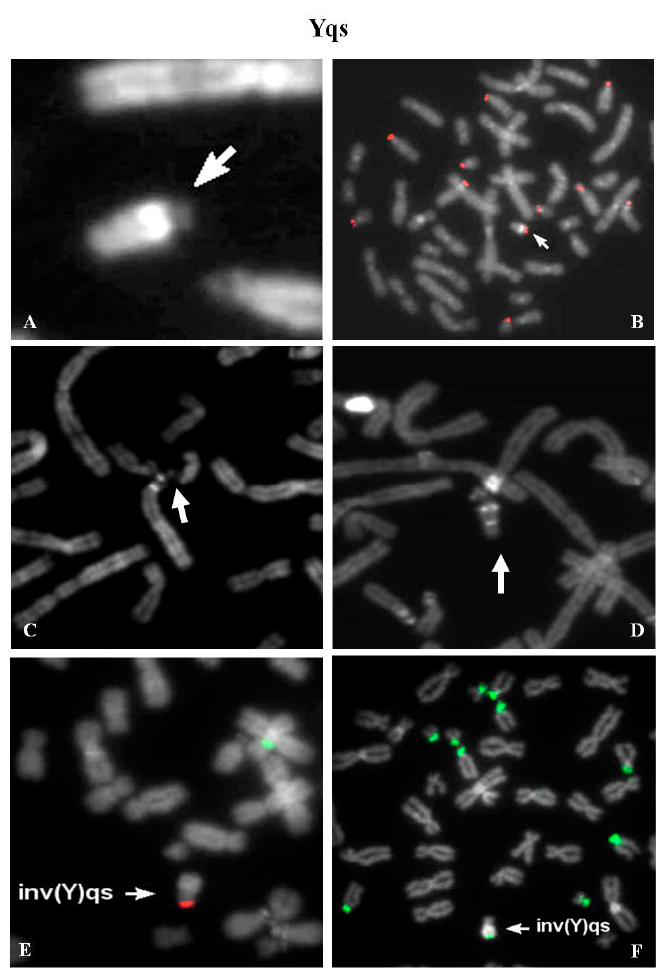
Figure 6. Yqs: ( A ) partial metaphase showing the satellited Yq (arrowed); ( B ) β -satellite probe signal on Yqs; ( C ) QFQ-banded Yq satellited chromosome with loss of heterochromatic region (Yqh − ); ( D ) netropsine–DAPI staining showed the presence of a small heterochromatic region on chromosome Yqh − satellited. Both metaphases ( C , D ) showed Yqs–acrocentrics association; ( E ) FISH on partial metaphase with SRY/CEPX probe (red and green signals): the chromosome inv(Y)(p11.2q11.23)qs showed the SRY signal in the canonical position; ( F ) FISH on partial metaphase with β -satellite probe evidenced hybridization signal at the end of the heterochromatic region of inv(Y)qs. All images were captured at 100× magnification (see materials and methods for details).